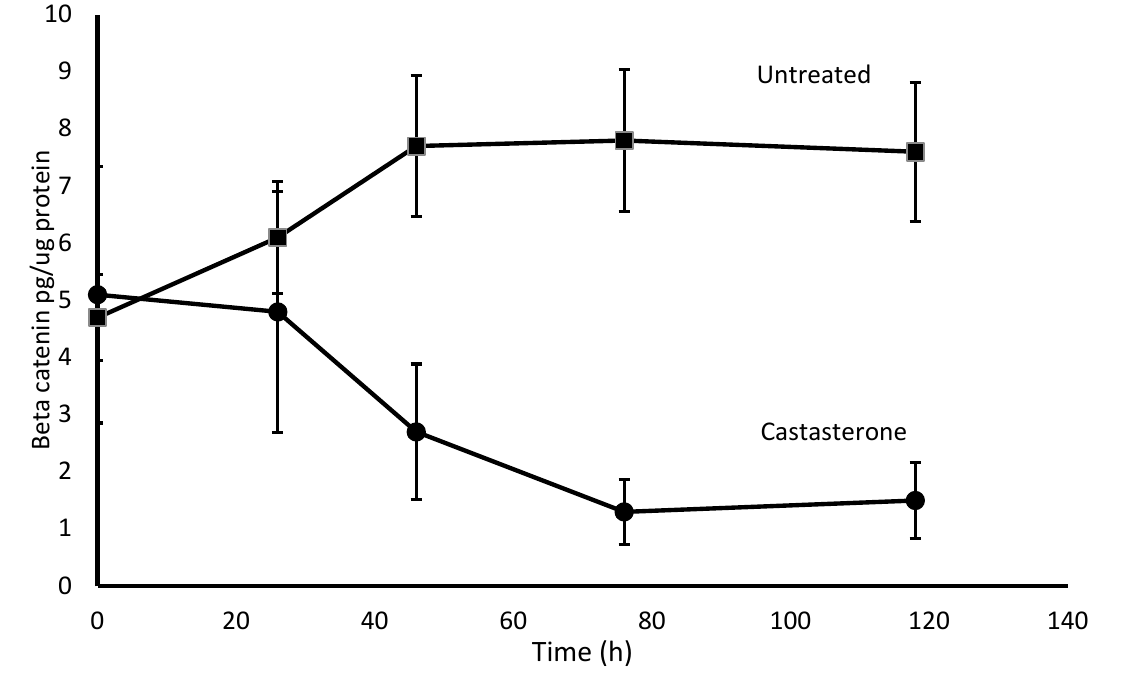
Figure 2. Time-dependent effect of castasterone on β -catenin in SCLC cells. H69 cells were incubated without (untreated) or with 0.5 μ M castasterone, and β - catenin and protein were measured at the indicated times in culture. Shown are the means ( ± S.D.) of the three experiments.